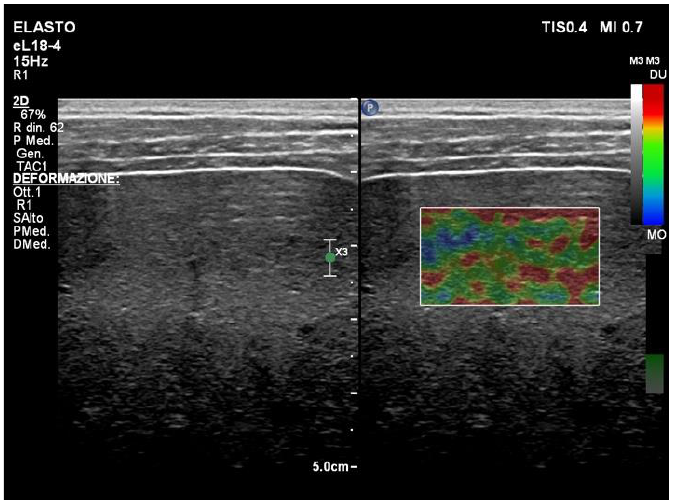
Figure 3. Strain elastography (Philips Medical System, Best, The Netherlands). The screen displays two images: conventional B-mode ultrasound image ( left ) and color-coded elastogram superimposed on B-mode ultrasound image ( right ). The region of interest marked by the white line should avoid large vascular